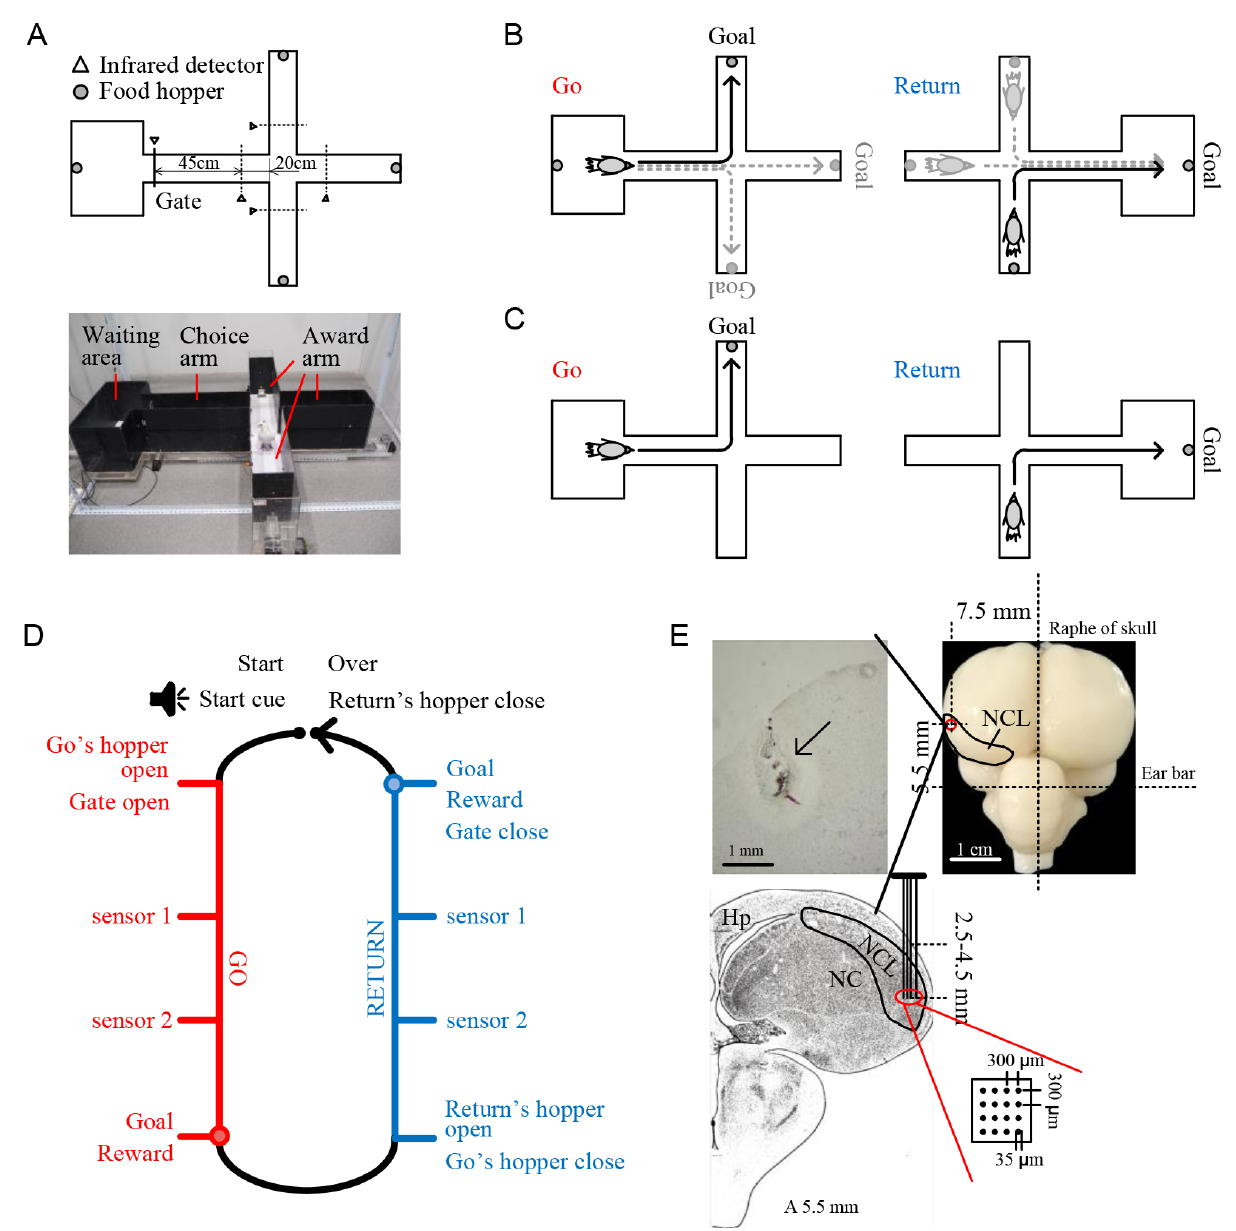
Fig. 1. Behavioral task and experimental procedures. (A) Diagram of experimental apparatus for pigeon. The infrared detector on the choice arm was defined as sensor 1, an infrared detector on the award arm was defined as sensor 2. (B) Diagram of the random-goal task. (C) Diagram of the fixed-goal task. (D) Experimental procedure. The red line represents going, and the blue line denotes returning. The arrow represents the direction of movement. (E) Implanting location of microelectrode array, which is denoted by red